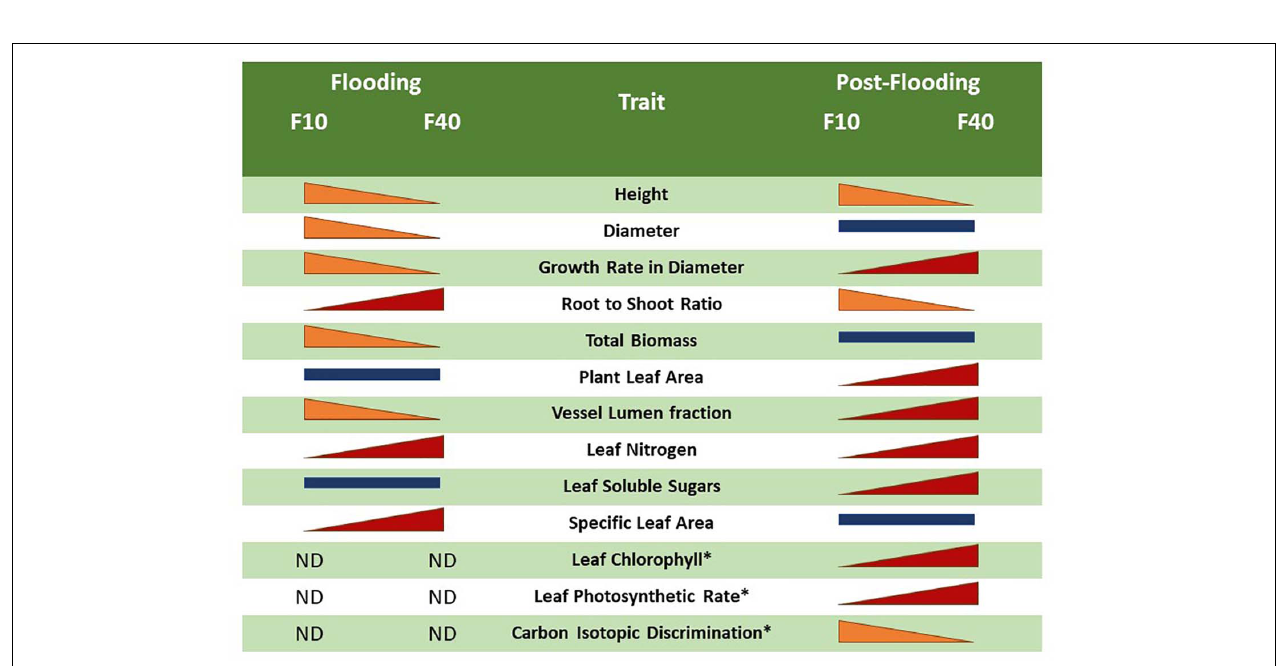
FIGURE 7 | Comparison between the flooding and post-flooding responses among the treatments F10 (plants flooded 10 cm above soil level) and F40 (plants flooded 40 cm above soil level). The change of size of the bars indicates whether a trait increased or diminished compared to the other flooding treatment. Bars of similar size indicates no significant differences between the flooding treatments. The symbol “*” represents an average of L1 and L2 leaves.